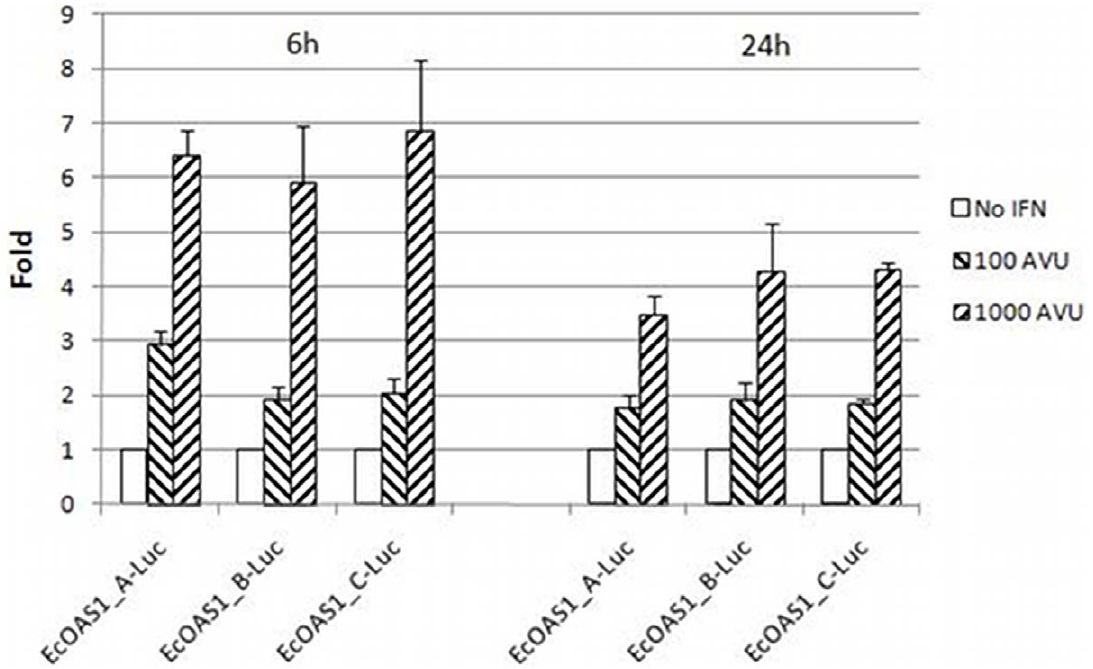
Figure 3. Effect of IFN on OAS1 -luciferase activity in HepG2 cells. HepG2 cells were transfected with the full-length OAS1 constructs and treated with 100 or 10 3 AVU IFN for 6 h or 24 h. A dose-response was observed for all clones, averaged across 4 replicates. Treating cells with 10 3 AVU IFN did not result in statistically significant differences in fold induction at either timepoint. However, when cells were treated with 100 AVU IFN, EcOAS1_A-Luc responded with greater fold induction than the other clones (ANOVA, p , 0.001). Pair-wise comparisons of EcOAS1_A-Luc to EcOAS1_B-Luc (p=0.001) and EcOAS1_C-Luc (p=0.003) resulted in statistically significant differences in fold induction after Bonferroni multiple test correction.